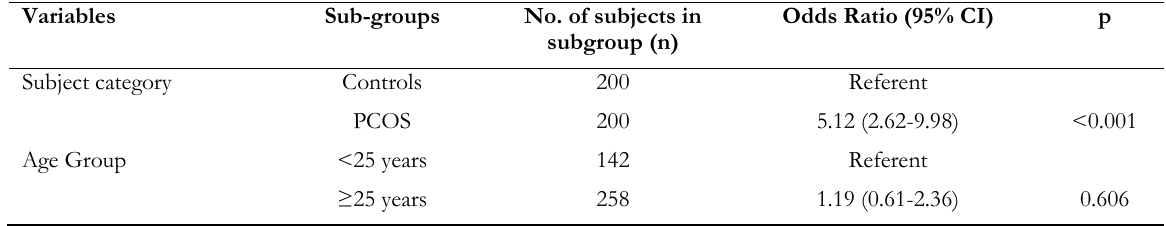
Table 2 Binary logistic regression for the predictors of major depression